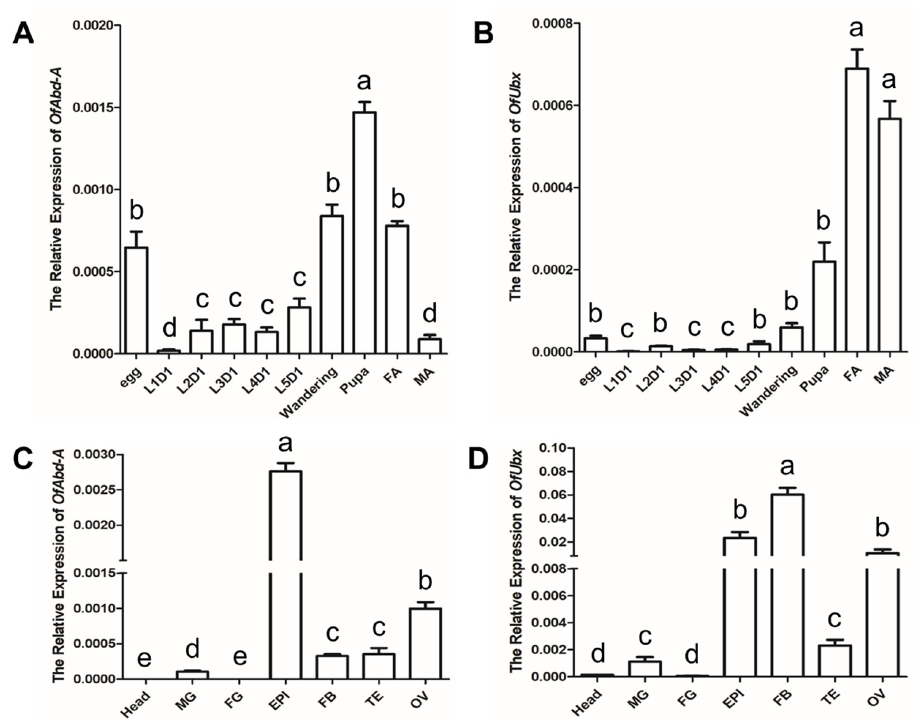
Figure 3. Spatial and temporal expression patterns of OfAbd-A and Ubx . The relative expressions of ( A ) OfAbd-A and ( B ) OfUbx in eggs, from the first day of first larval instar (L1D1) to the first day of fifth larval instar (L5D1), and at wandering stage, pupal stage, female adult stage (FA), and male adult stage (MA). The relative expressions of ( C ) OfAbd-A and ( D ) OfUbx in head, midgut (MG), foregut (FG), fat body (FB), epidermis (EPI), testes (TE), and ovaries (OV) at the third day of fifth instar (L5D3). Means labeled with different letters indicate significant difference at p < 0.05 ( n = 3).